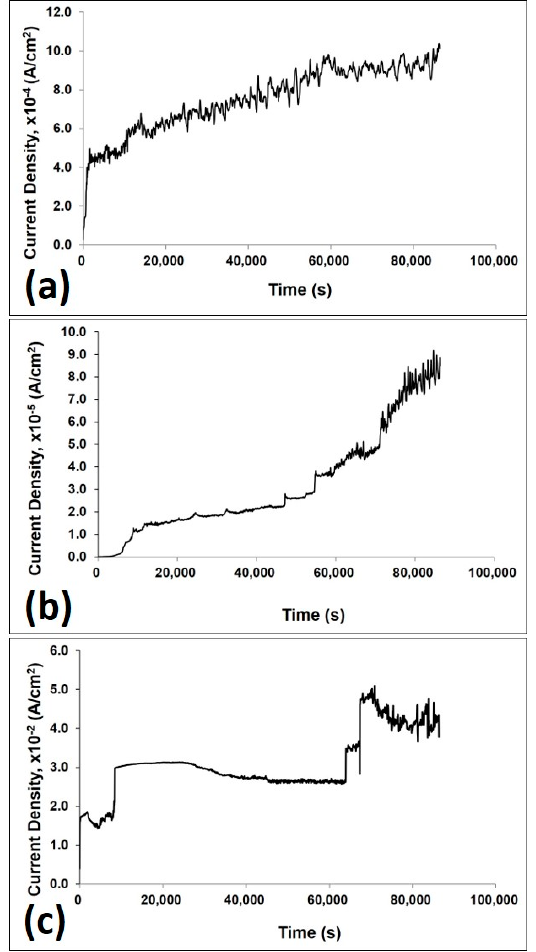
Figure 5. Current density versus time plots to calculate charge transfer for coating by ( a ) HA, ( b ) PEO and ( c ) PSC at +400 mV (Ag/AgCl).